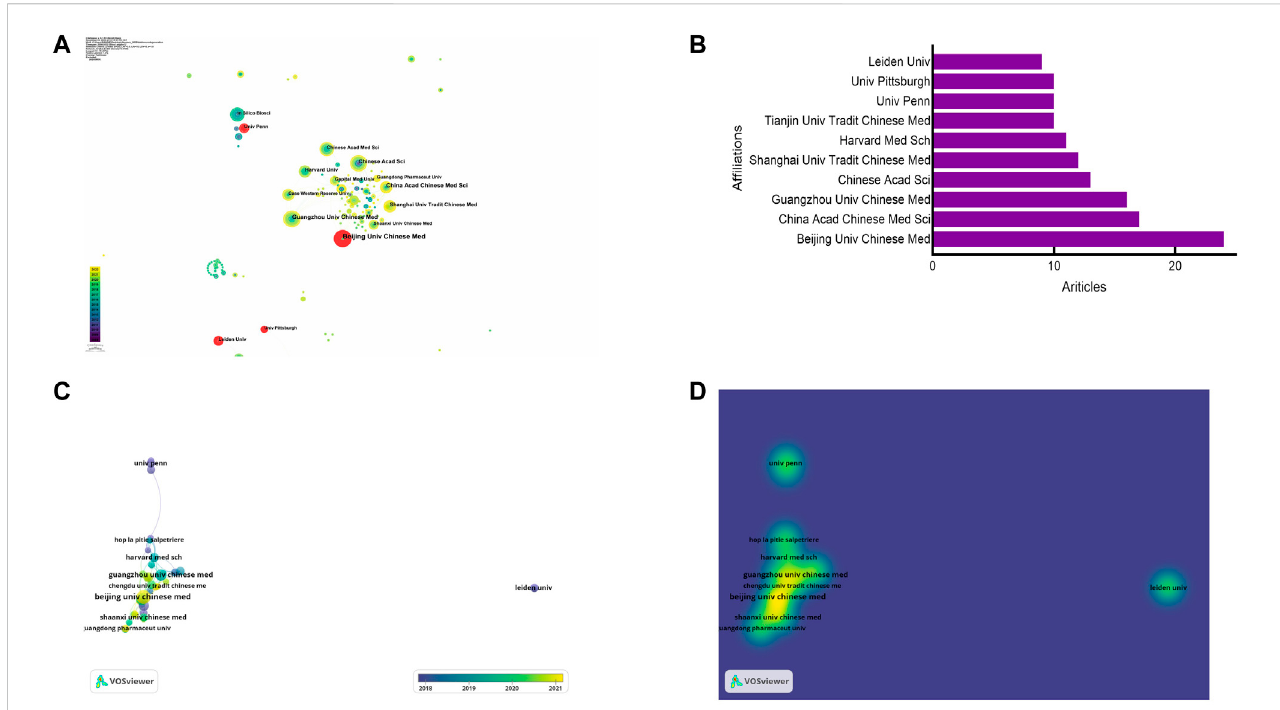
FIGURE 4 Analysis of institutions. (A) Visualization of institutions involved in network pharmacology in NDs. (B) Top 10 institutions of publications. (C) Cooperation network of institutions. (D) Density map of institutions